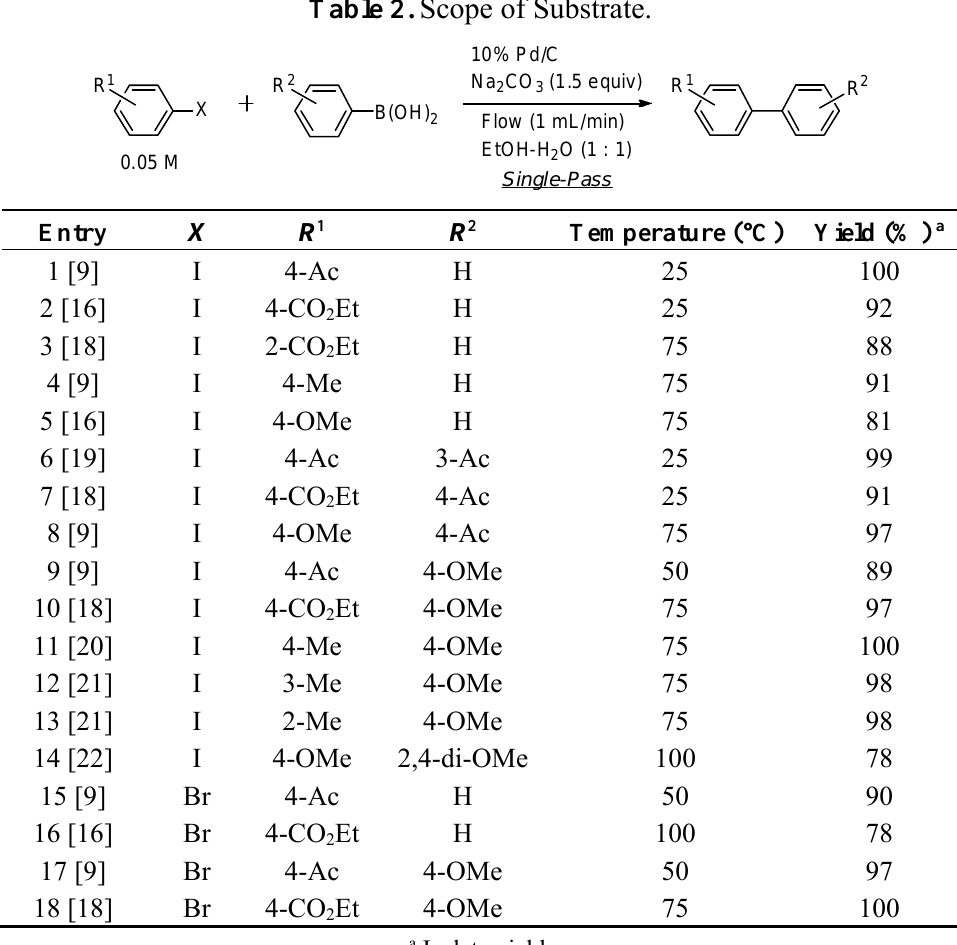
Table 2. Scope of Substrate.